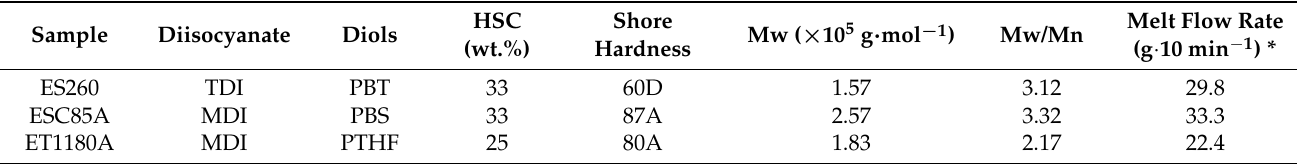
Table 1. Hard segment content (HSC), Shore hardness of materials, molecular weight, Mw/Mn, melt flow rate and compositions of three neat TPU.